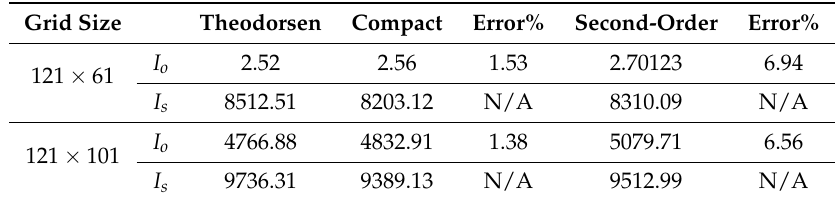
Table 2. Comparison of I o and I s over the entire computational region with O-type grids generated around a NACA 0012